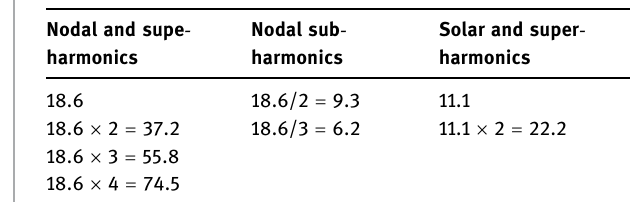
Table 1: Selected compounded luni - solar periods in